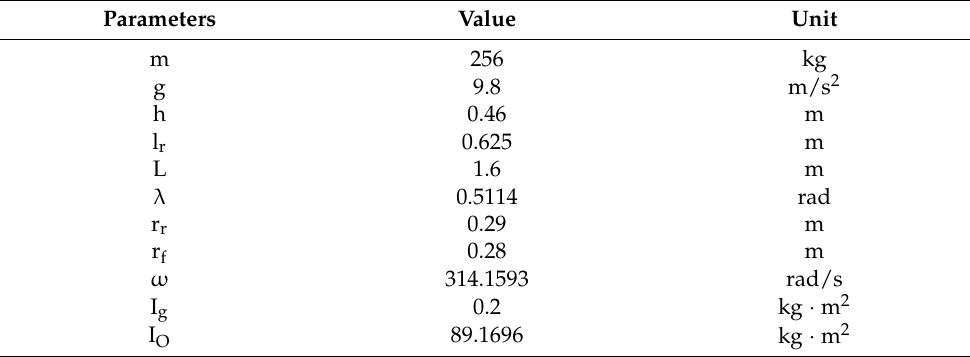
Table 1. Parameters of motorcycle and SGCMG.